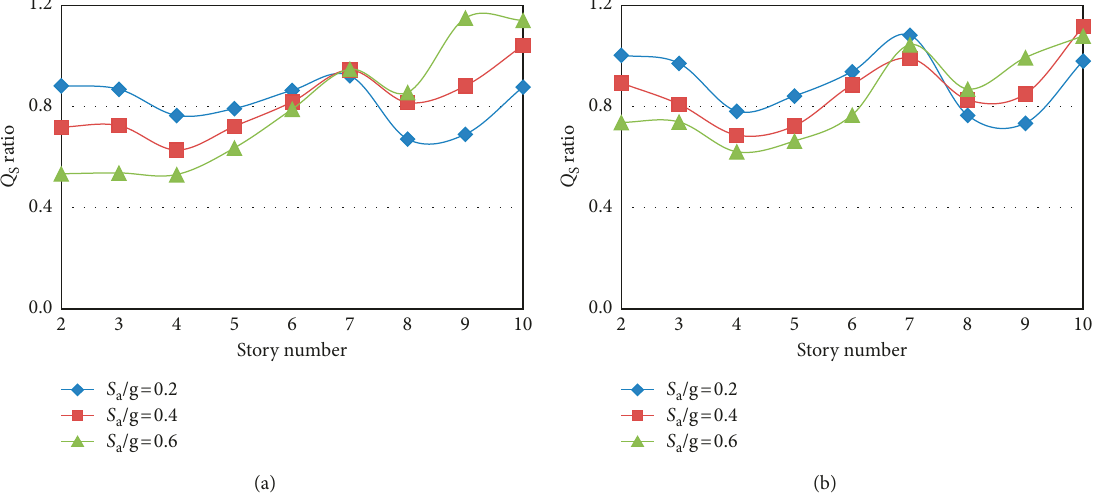
Figure 6: 10-level building, Q S ratio: (a) NS direction; (b) EW